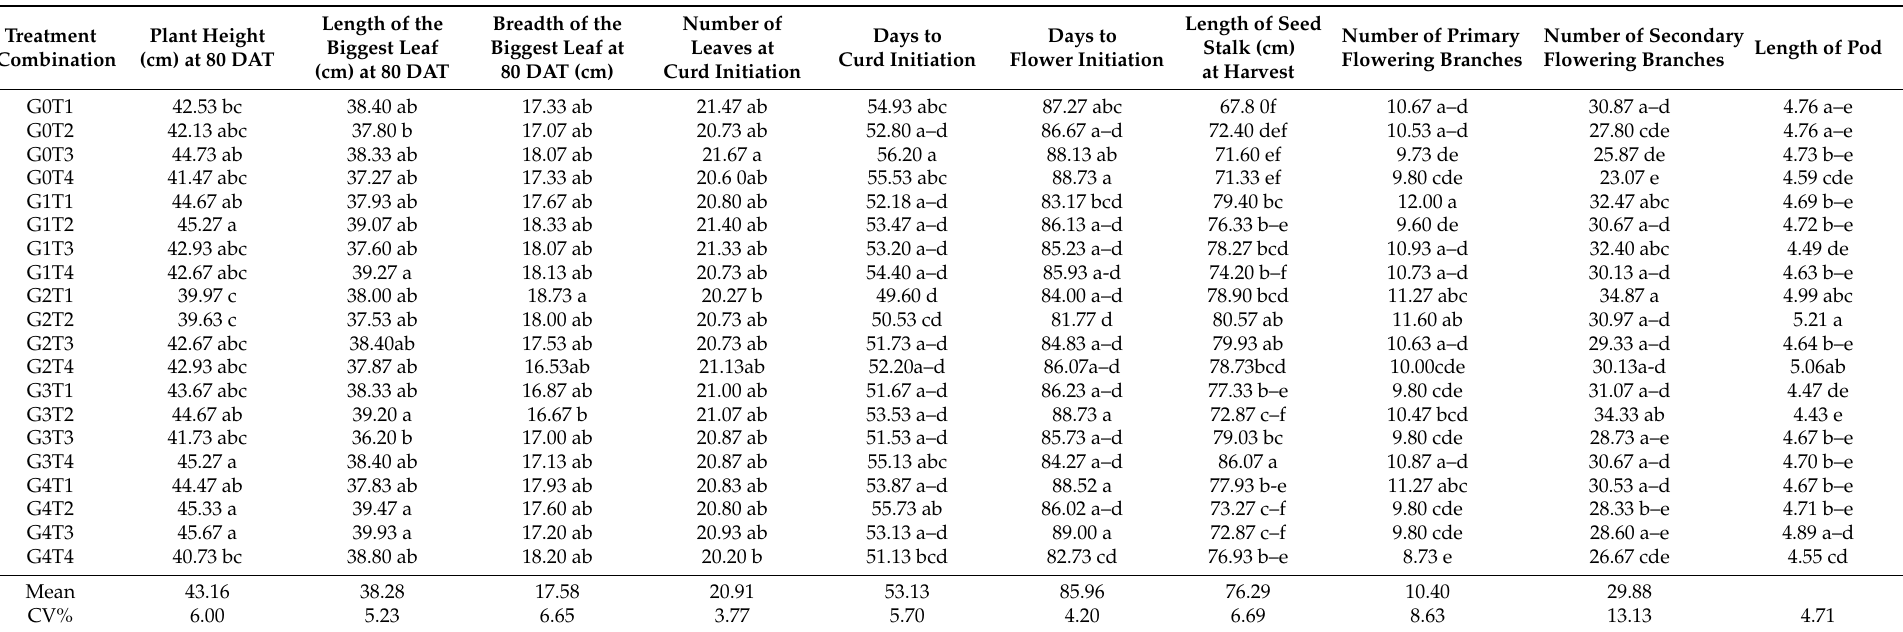
Table 3. Interaction effect of GA 3 and time of application on morpho-phenological traits in BU cauliflower-1. Treatment